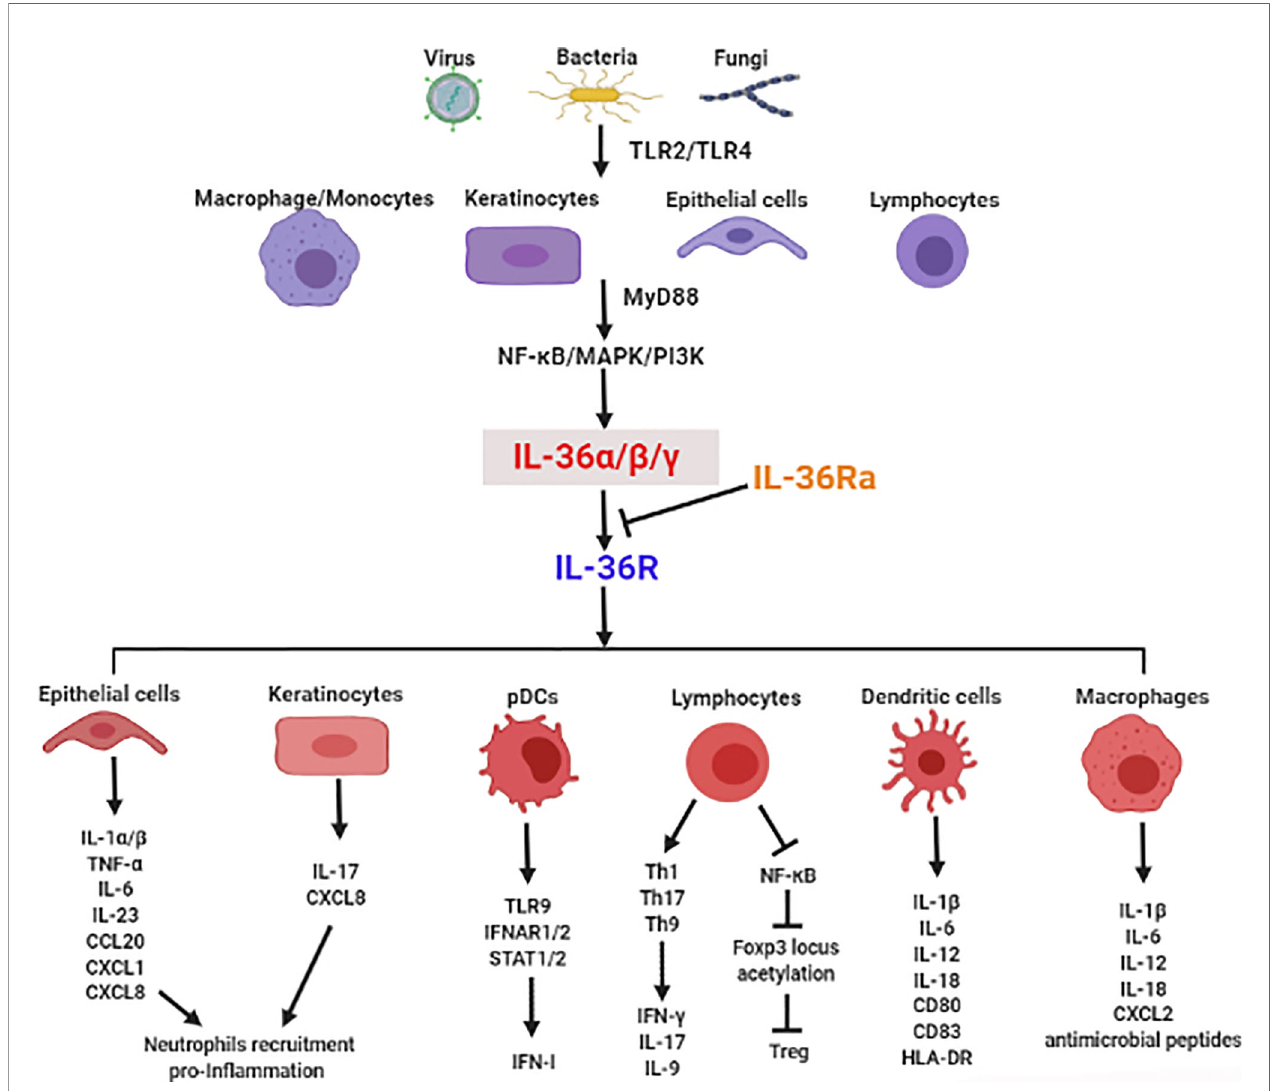
FIGURE 1 | The crucial role of IL-36 in induction of in fl ammatory cytokines, recruitment of immune cells, modulation of immune cell activation and differentiation, and maintenance of mucosal integrity and barrier function in infectious